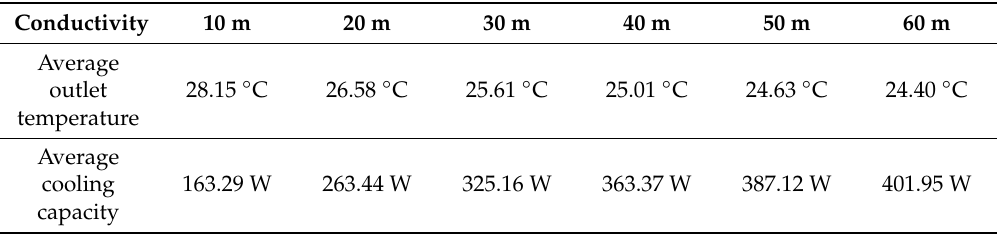
Table 2. The average outlet temperatures and cooling